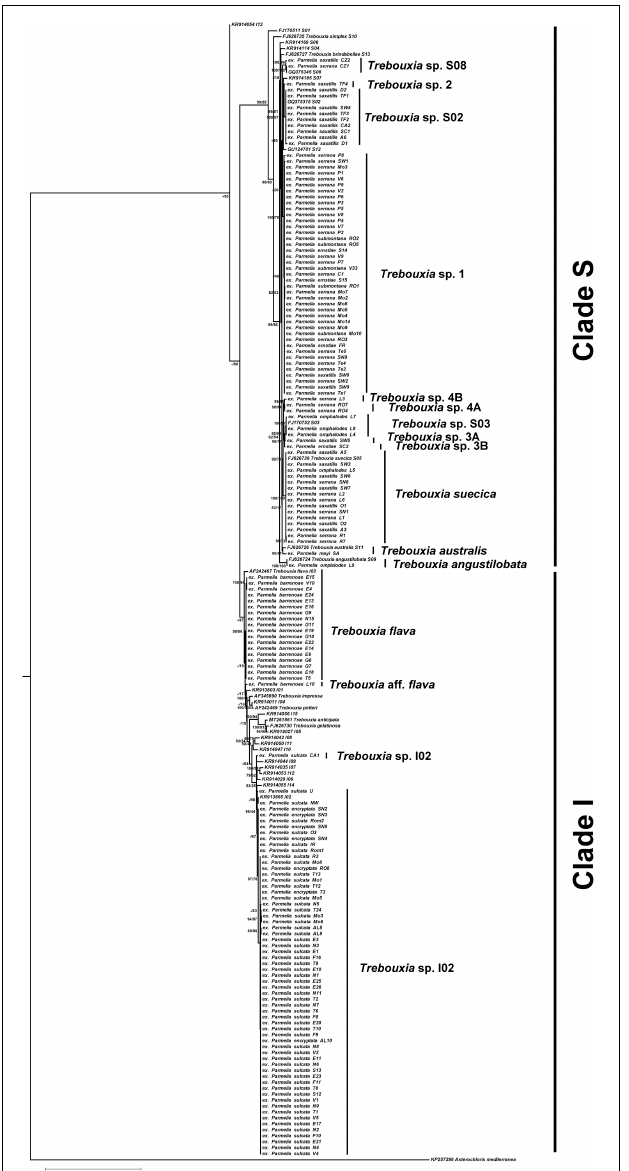
FIGURE 2 | Trebouxia phylogenetic analysis. Rooted nrITS gene tree representing 192 Trebouxia sequences, including 10 well–accepted Trebouxia species from SAG and UTEX retrieved from the GenBank. Newly generated sequences are marked as ex Parmelia spp._locality-code_number. Fifteen Trebouxia species detected were indicated. Values at nodes indicate statistical support estimated by two methods: bootstrap support (BS, RAxML analysis) and posterior probabilities (PP, MrBayes analysis). Scale bar shows the estimated number of substitutions per